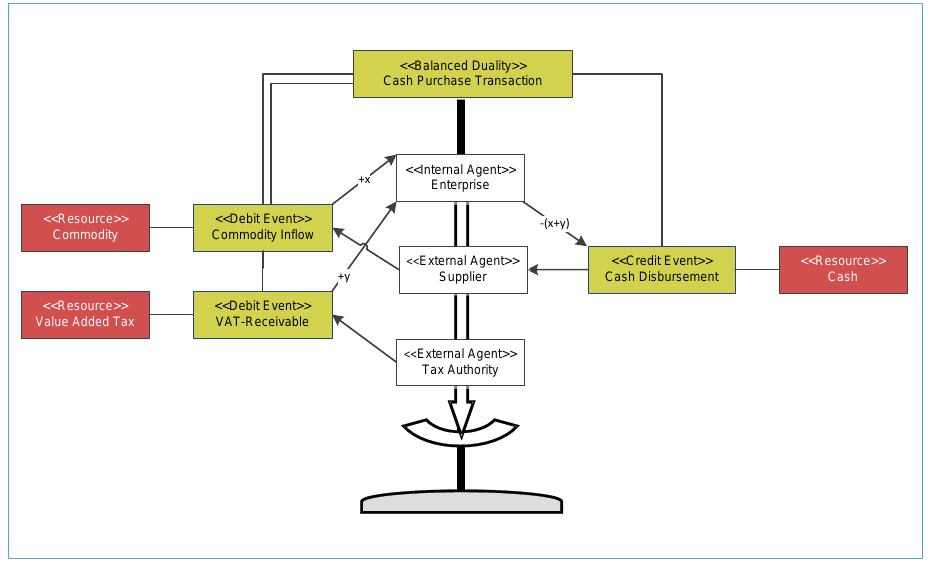
Figure 7. Balanced Duality relationship – cash purchase